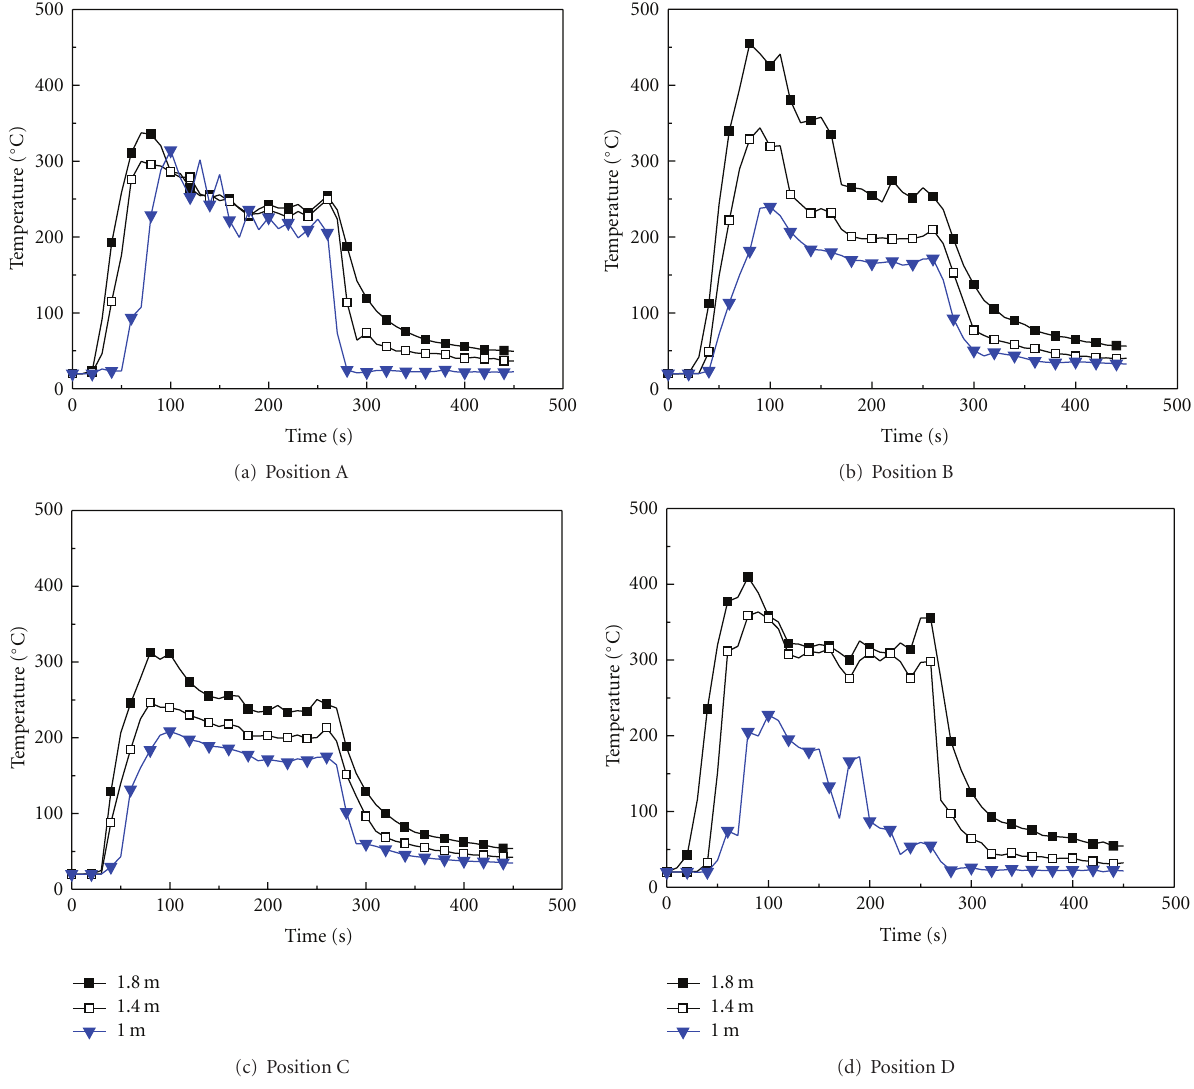
Figure 5: Temperatures at positions A, B, C, and